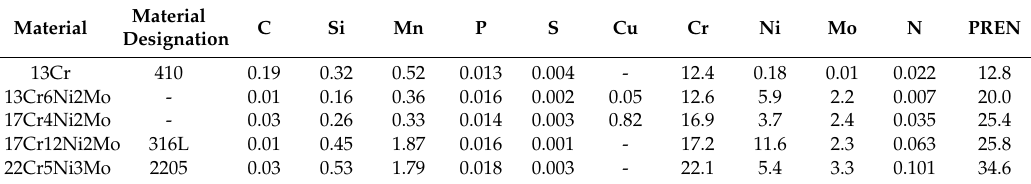
Table 1. Chemical composition and pitting resistance equivalent number (PREN) of investigated materials